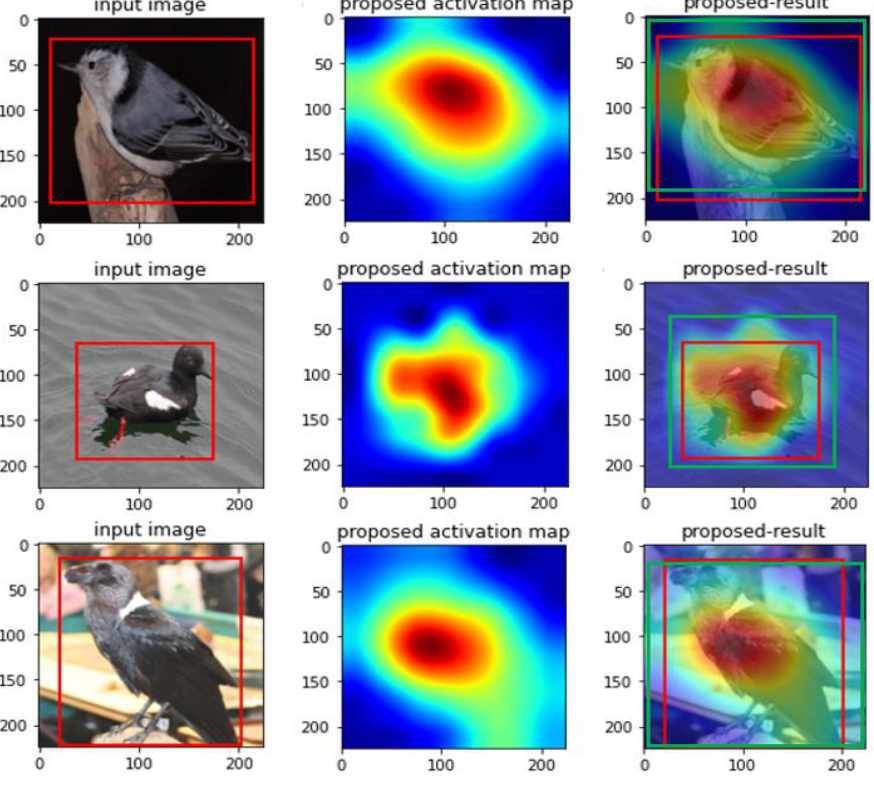
Figure 5. Results of the proposed method (1) .